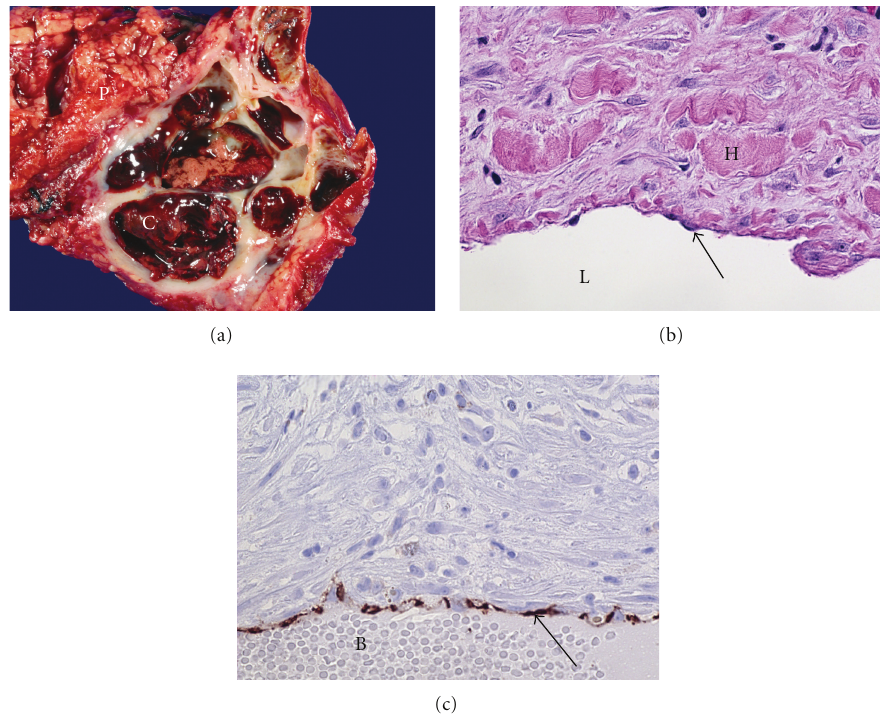
Figure 2: (a) Gross pathology specimen. 5.5cm hemangioma containing denuded multiloculated cysts (C) with intracystic hemorrhage. Pancreatic acinar tissue (P). (b) Hematoxylin and eosin stain (160x) of specimen demonstrating cyst lumen (L) lined with endothelial intima (arrow) and surrounded by media rich in hyalinized collagen (H). (c) CD31 stain (160x) of specimen with strong staining of endothelial intima (arrow). Blood in cyst lumen